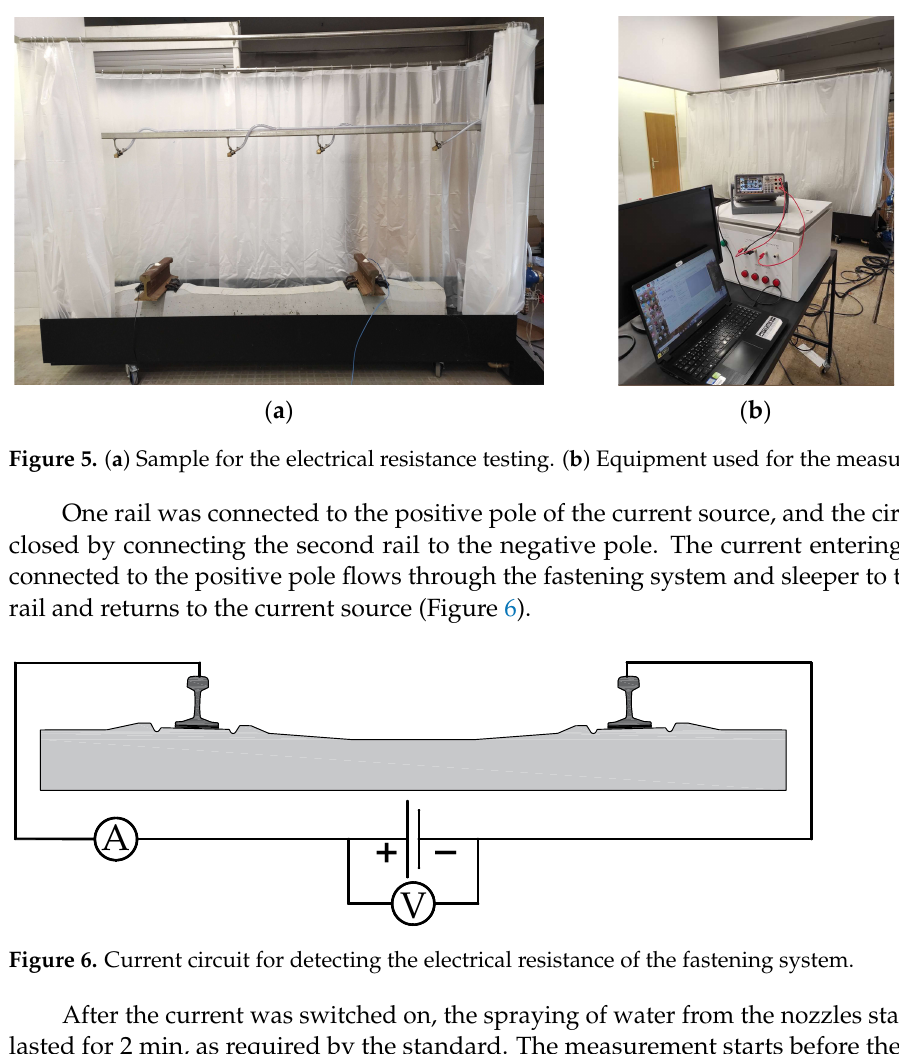
Figure 5. ( a ) Sample for the electrical resistance testing. ( b ) Equipment used for the measurement.